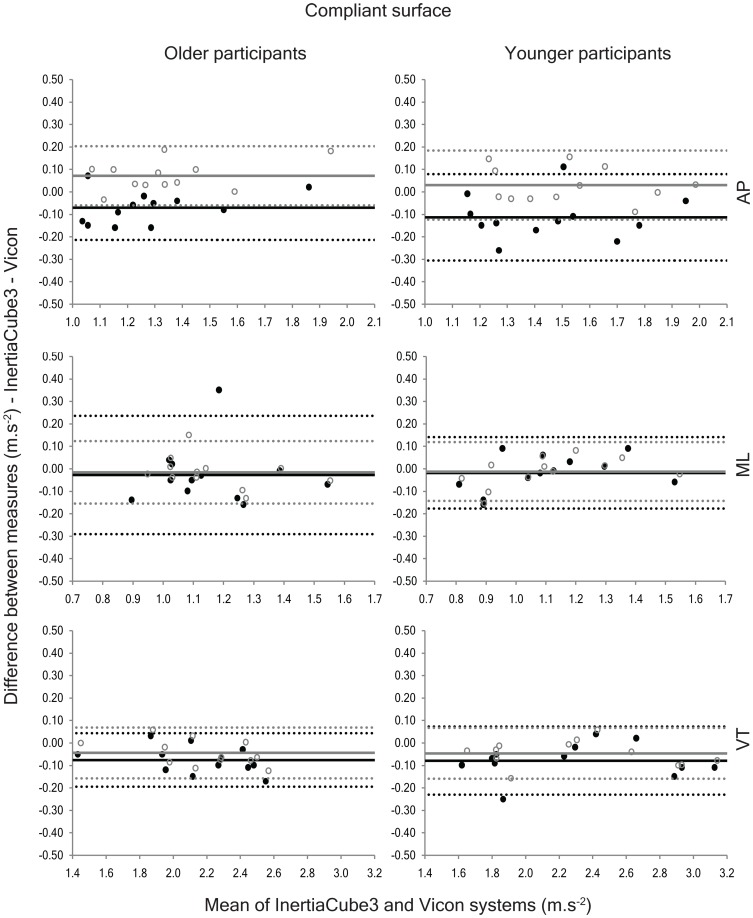
Bland-Altman plots portraying the agreement between the anteroposterior (AP), mediolateral (ML) and vertical (VT) accelerations collected using the InertiaCube3 and Vicon systems while walking on the compliant surface.The solid black circles represent the agreement between the two instruments using the detrending method and the open grey circles show the agreement using the quaternion method. The solid lines depict the systematic bias between the two measures and the dashed lines represent the 95% limits of agreement (black = detrending method; grey = quaternion method).